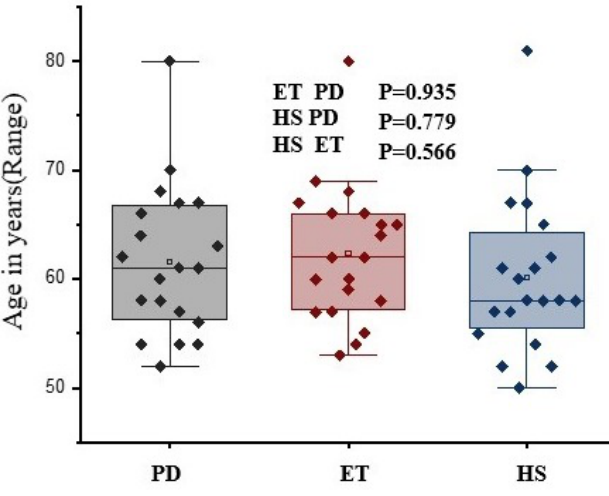
Figure 1. Comparison of mean age of the participants. Table 2. Baseline characteristics of Parkinson’s disease subjects, essential tremor and healthy